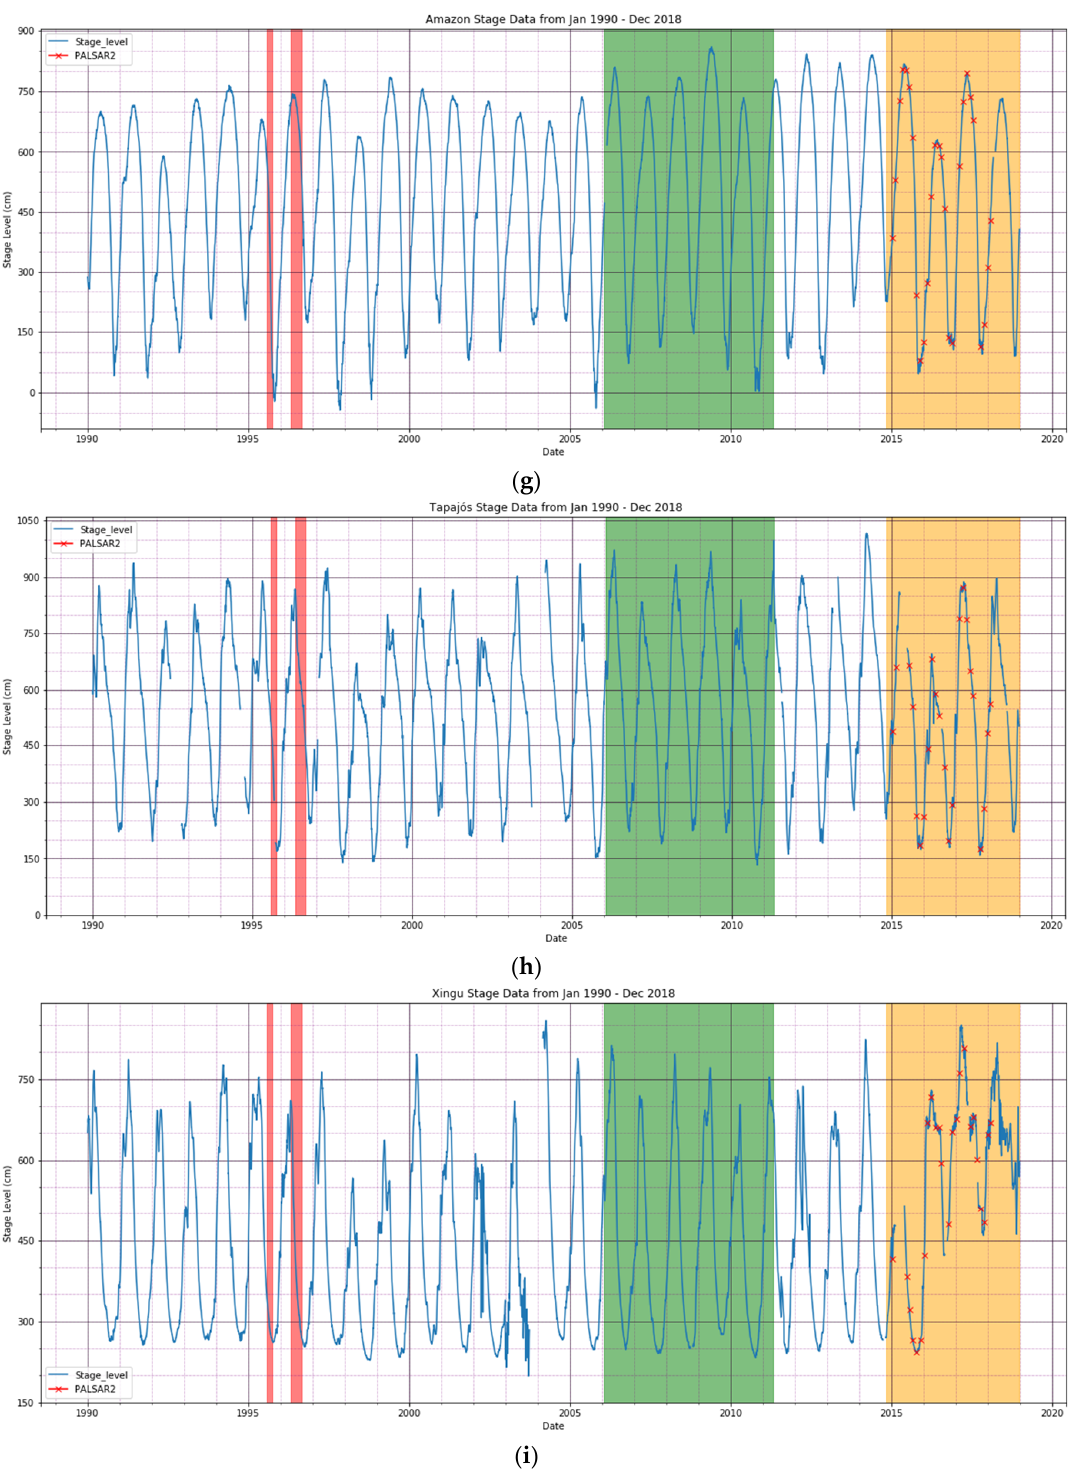
Figure A1. (a) River stages 1990–2018. Station o-326, Estirão do Repouso, Rio Javari Figure A1. ( a ) River stages 1990–2018. Station o-326, Estir ã o do Repouso, Rio Javari (S4.341 ◦ / W70.906 ◦